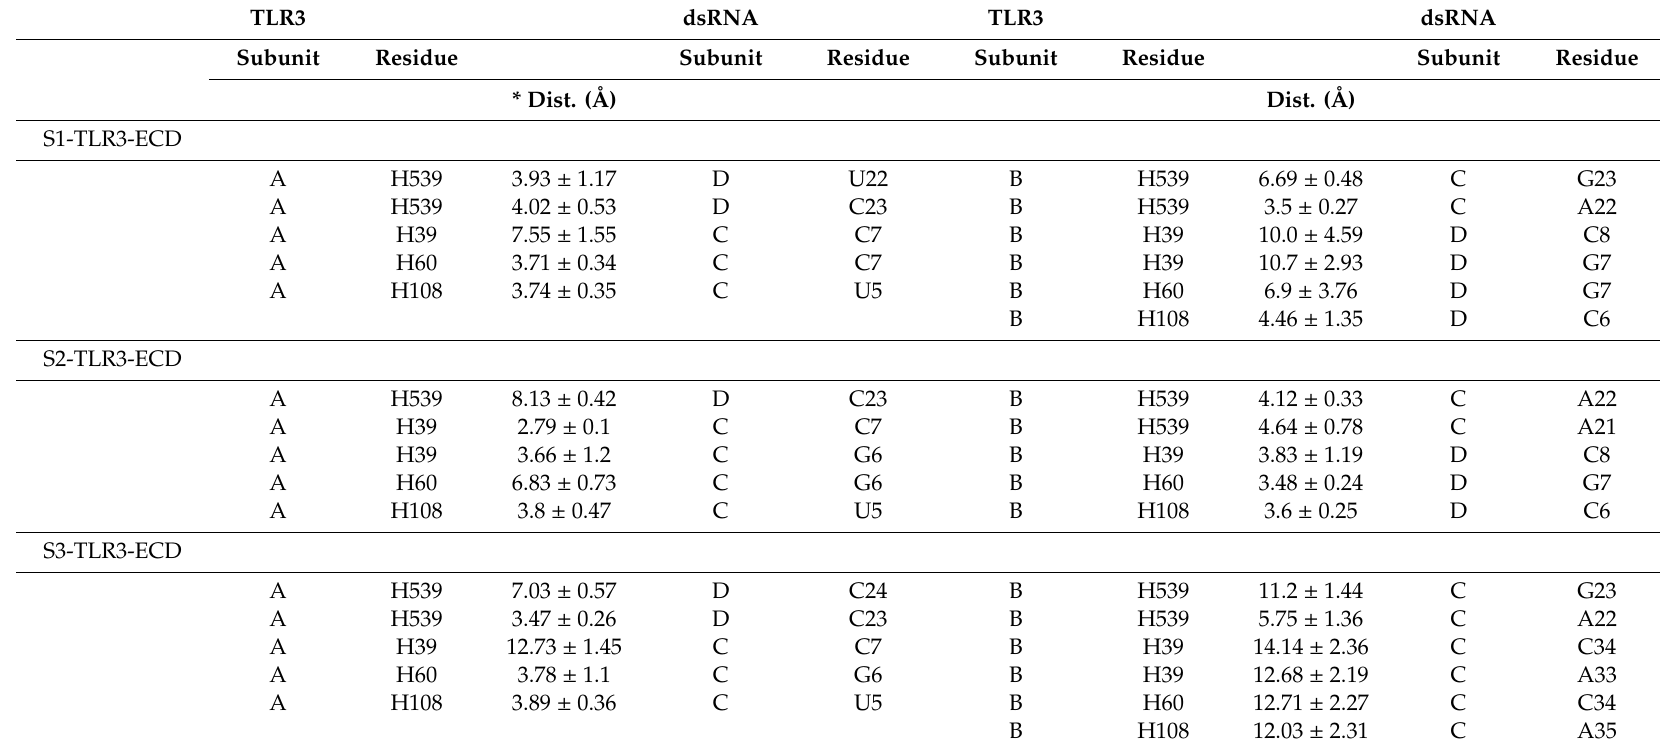
Table 2. Average distance between histidine imidazole and dsRNA phosphate